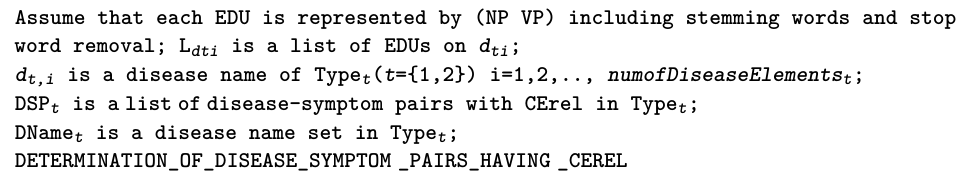
Algorithm 1 DeterminationOfDiseaseSymptomPairsHavingCErel